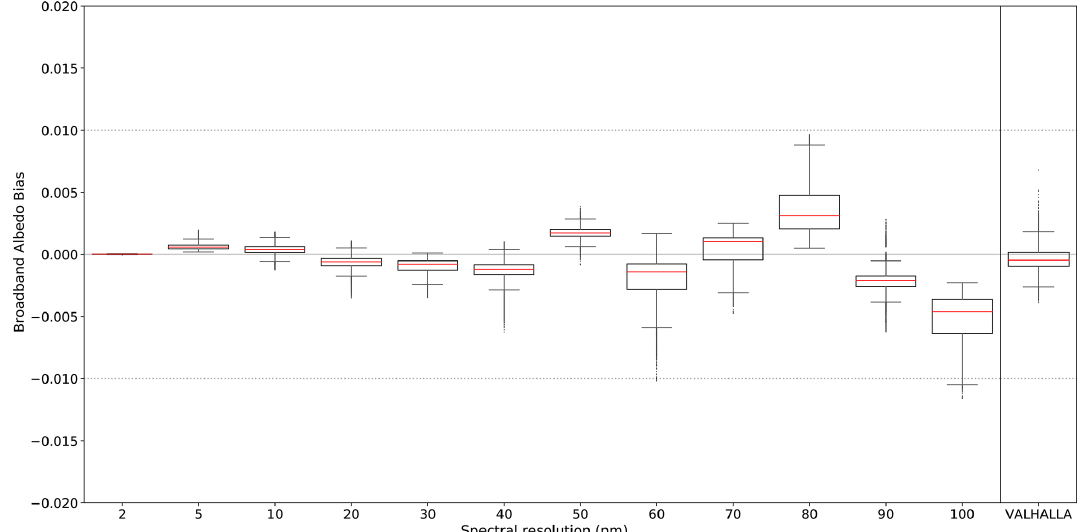
Figure 6. Errors on the broadband albedo for different constant spectral resolutions (left) and comparison with the errors of our method (right). For these resolutions, the broadband albedo is computed by TARTES–SBDART and is compared to the one computed at 1nm resolution. The red lines indicate the median (same as in Fig. 2), the box shows the 25th to 75th percentiles, and the whiskers show the 5th to 95th percentiles. The grey dotted lines correspond to an error of ± 0 . 01 as in Gardner and Sharp